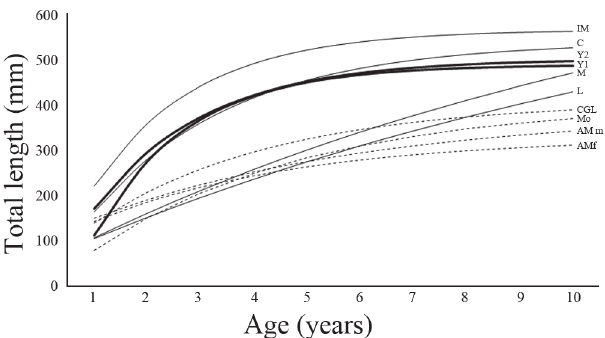
Fig. 6. Von Bertalanffy growth curves of trahira Hoplias